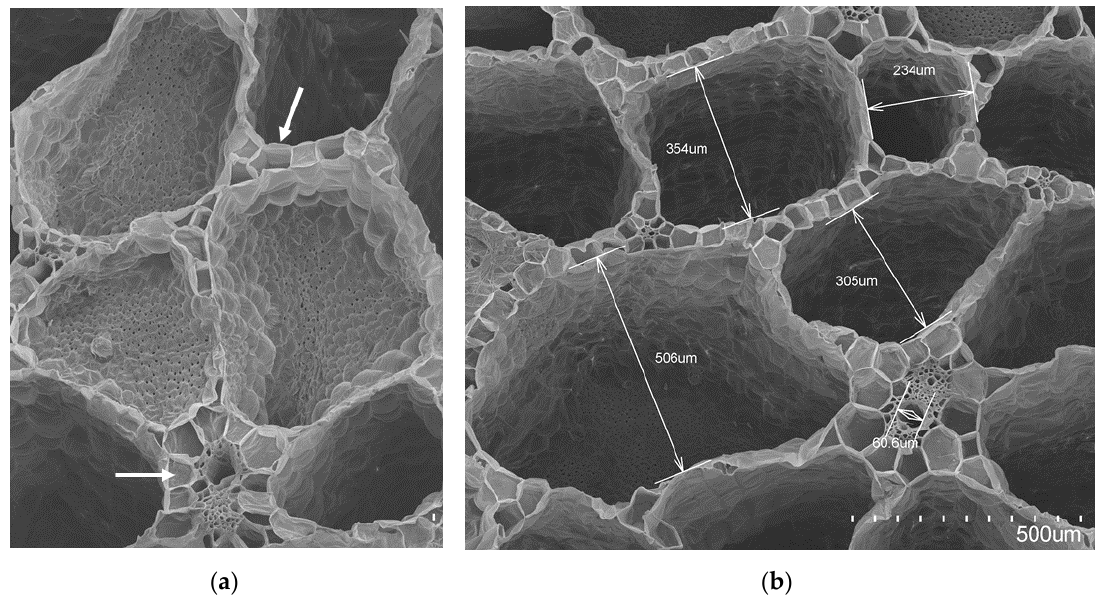
Figure 5. Internal structure of the petiole section, SEM view. Parenchymatous cells ( a ) and aerenchyma tissue ( b ), measured in four air chambers.